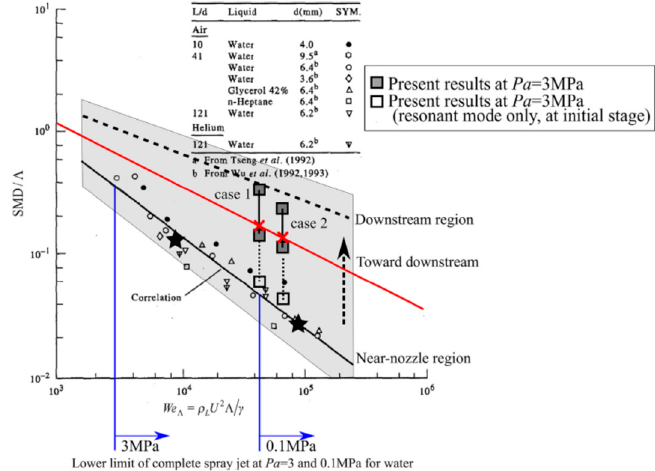
Figure 17. Comparison of SMD with data from Faeth et al . [65,71]. The gradual trend of increased SMD toward downstream (indicated by the hatched gray region) is predicted in the simulation (case 1 and case 2).